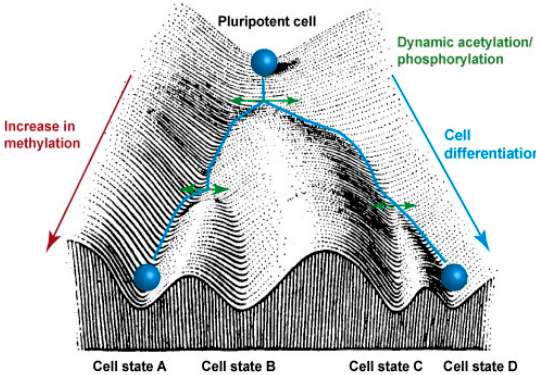
Figure 2. Waddington’s epigenetic landscape. This image provides an analogy of how the pluripotent stem cells give rise to specialized cells as they undergo epigenetic changes, such as methylation, acetylation and phosphorylation (adopted from [23] Copyright 2010 with permission from Elsevier).